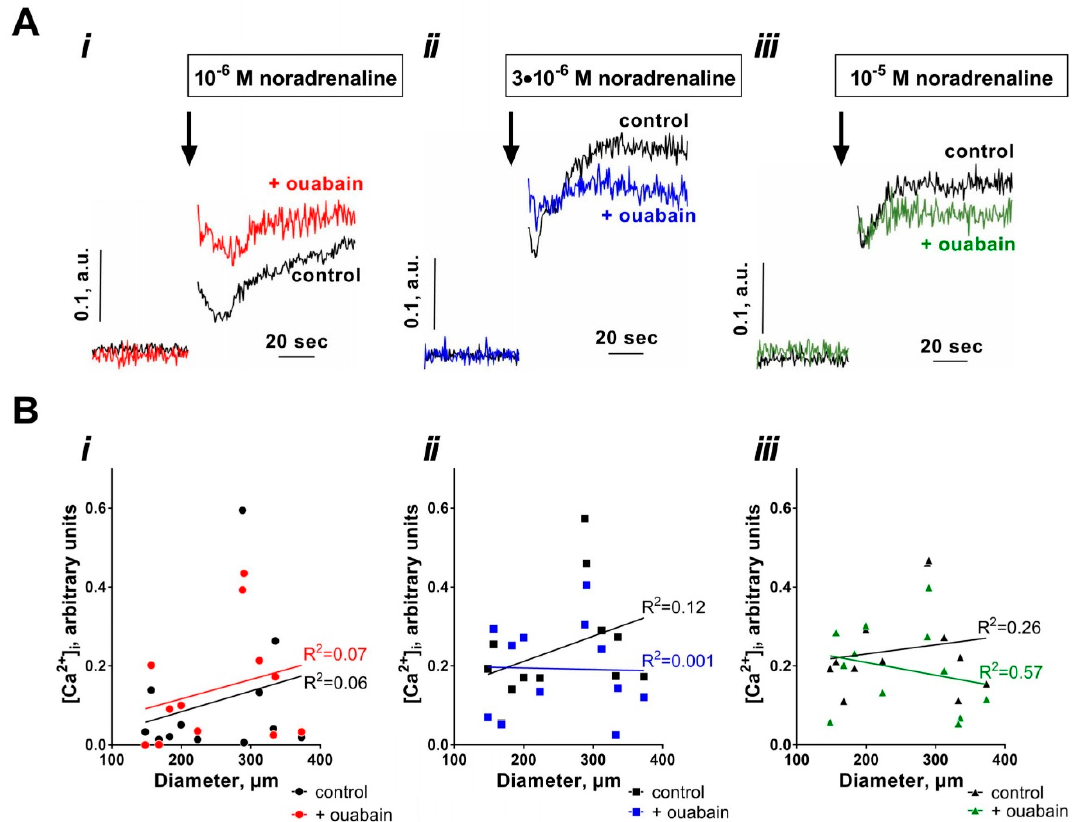
Figure 3. Noradrenaline-induced changes in intracellular calcium ([Ca 2+ ] i ) do not correlate with arterial diameter. Mesenteric arteries of different diameters were loaded with the Ca 2+ -sensitive dye (Fura-2/AM) to access wall tension (showed in Figure 2) and [Ca 2+ ] i changes in response to stimulation with either 1 µ M ( i ), 3 µ M ( ii ) or 10 µ M ( iii ) noradrenaline. Representative curves for [Ca 2+ ] i are shown in ( A ). ( B ) shows that averaged noradrenaline-induced changes in [Ca 2+ ] i did not correlate with arterial diameter. Linear regression quantifies goodness of fit with R 2 as indicated by the lines. No significant correlation was found. n = 12.